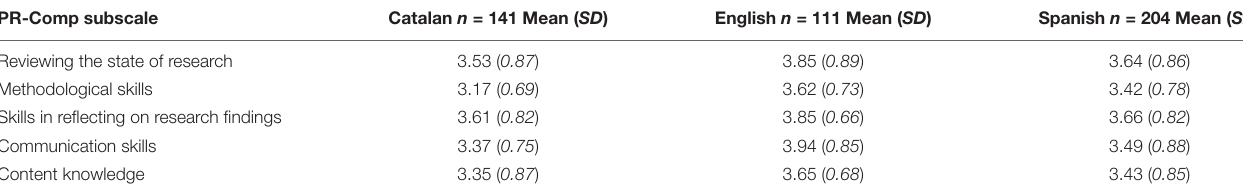
TABLE 3 | Descriptive statistics for PR-Comp